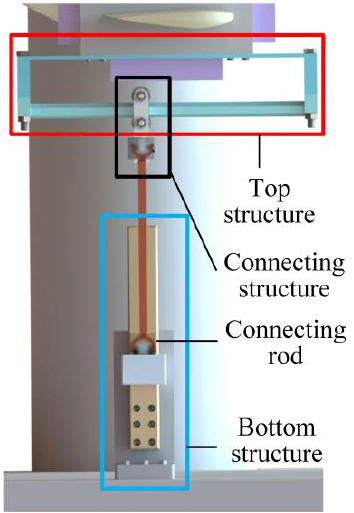
Figure 15. New synchronous force decoupling structure.